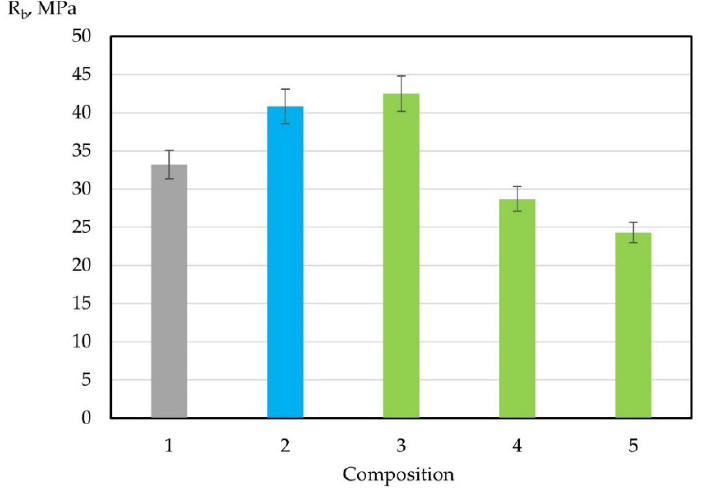
Figure 7. Change in axial compressive strength of concrete samples at the age of 28 days: 1 (grey)—control composition; 2 (blue)—electromagnetically treated cement paste without RSA; 3, 4, 5 (green)—electromagnetic treated cement paste with RSA of different dosage according to Table 6.